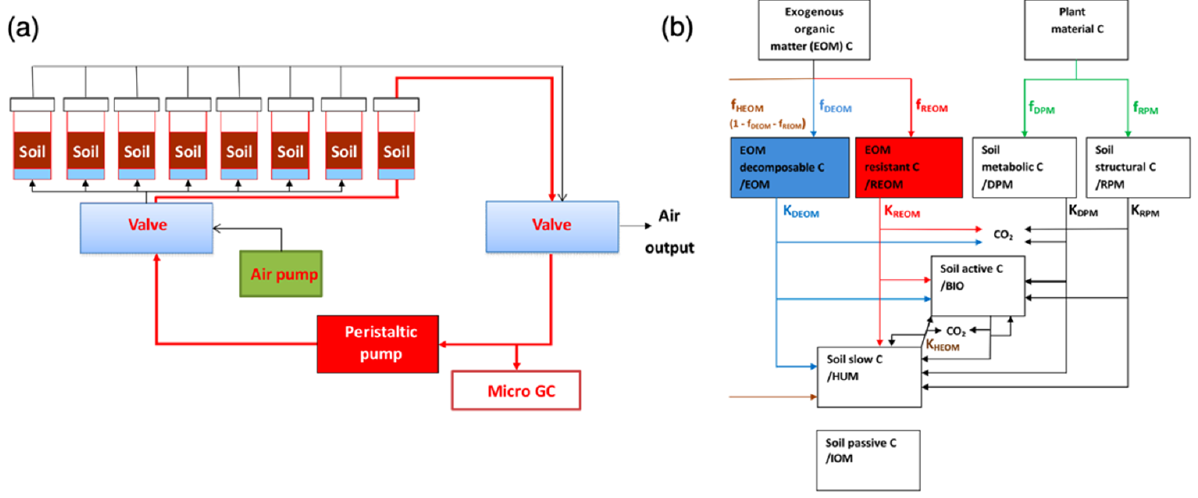
Figure 1. Diagram of the automated chromatographic system for soil CO 2 sampling and measure- ment ( a ) and structure of the modified RothC model ( b ). DPM: decomposable plant material; RPM: resistant plant material; EOM: exogenous organic matter; DEOM: decomposable EOM; REOM: re- sistant EOM; HEOM: humified EOM; BIO: soil microbial biomass; HUM: humified soil organic mat- ter; IOM: inert organic matter; f : partitioning factor; K : decomposition constant rate (yr − 1 ). Figure adapted from Mondini et al. [26].